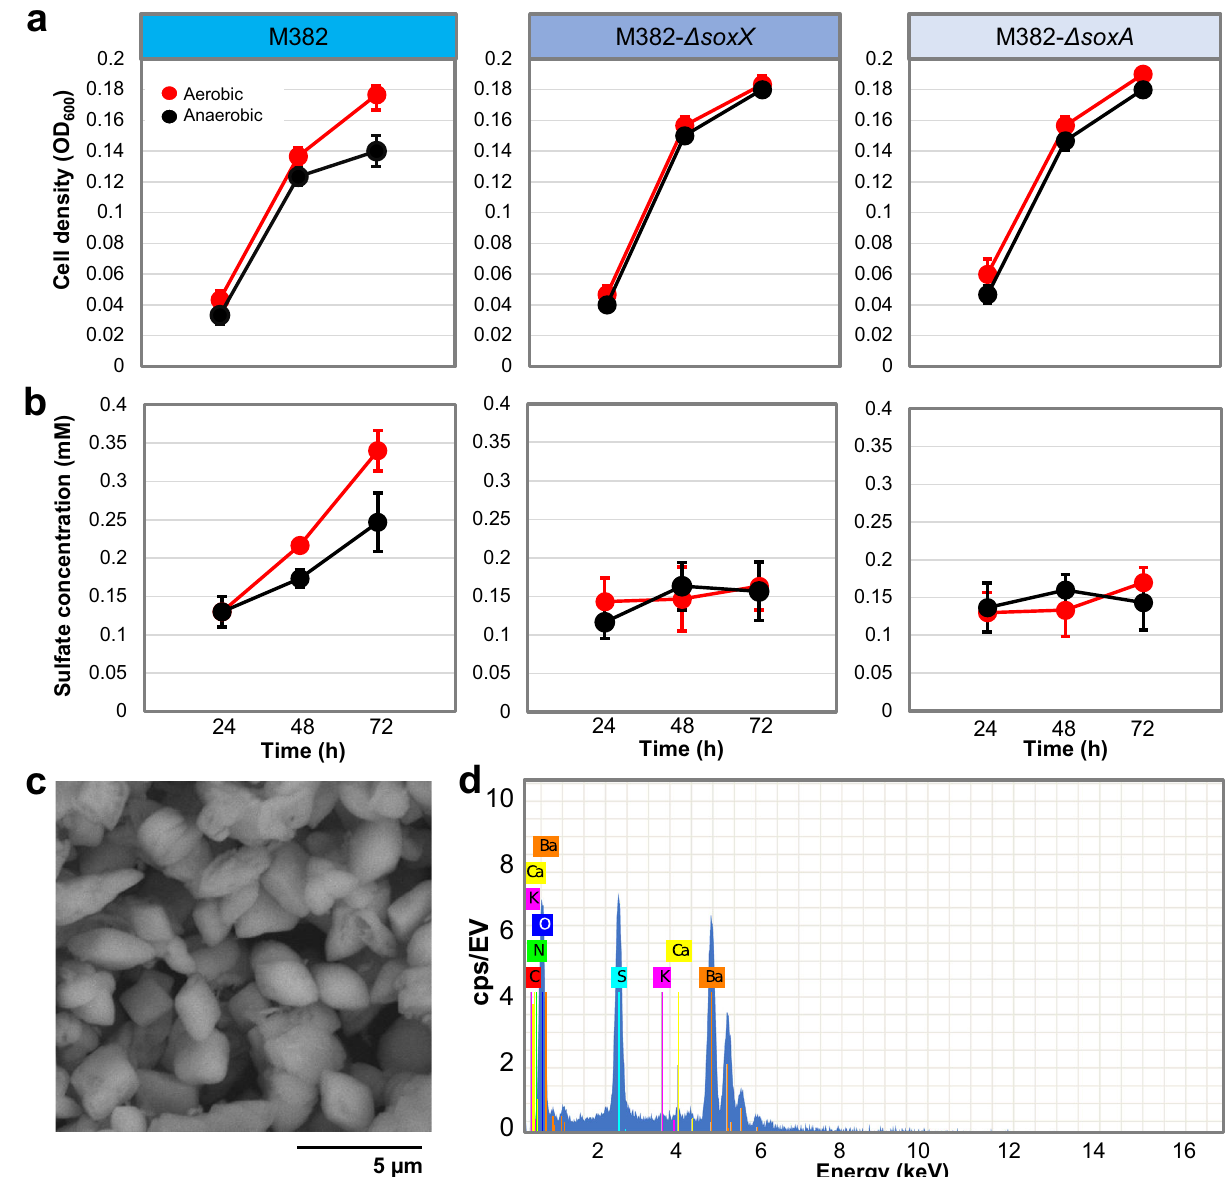
Fig. 4 | Experimental study of thiosulfate oxidation by Rhodobacteraceae sp. M382. Thewild-typeM382anditstwomutantstrainsweregrownplanktonicallyin minimum media with 10mM thiosulfate, followed by measurement of optical densities of the cells at 600nm ( a ) and the sulfate concentrations in the media ( b ) at three time points. Values are shown as mean±s.d. ( n =3